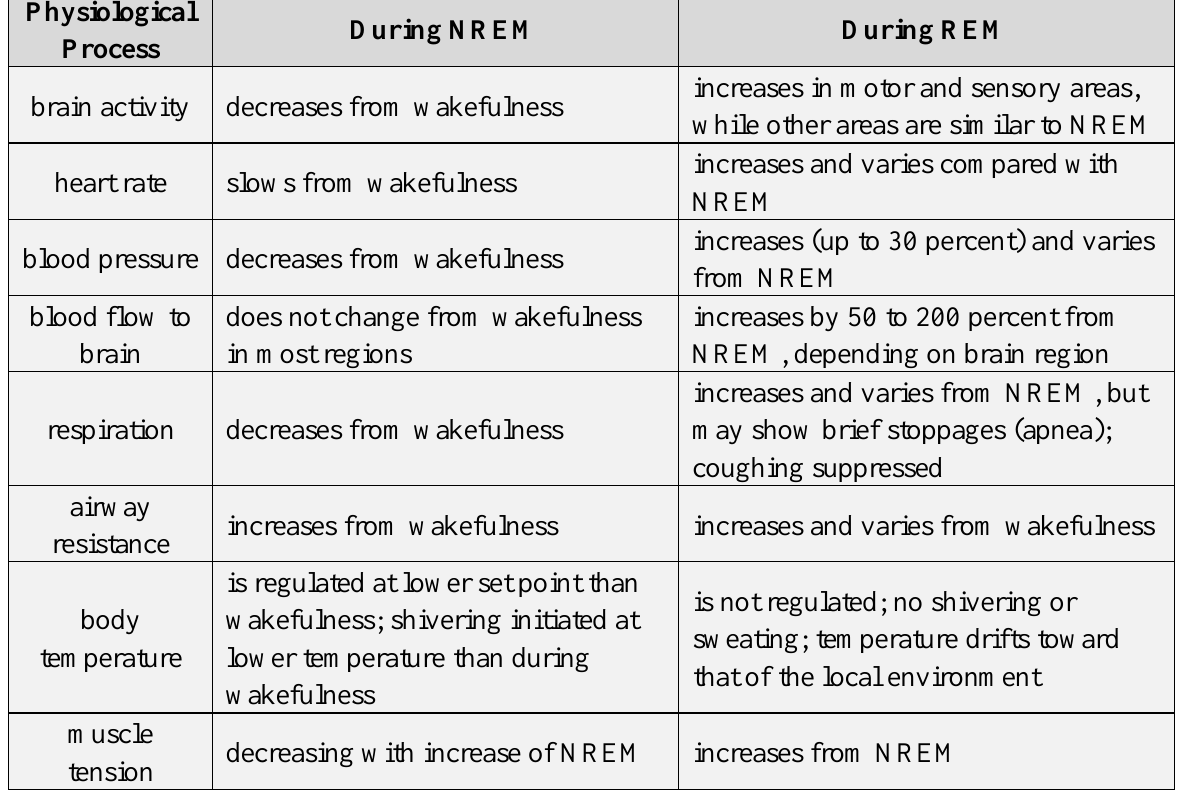
Table 1. Biological manifestations in sleep stages.